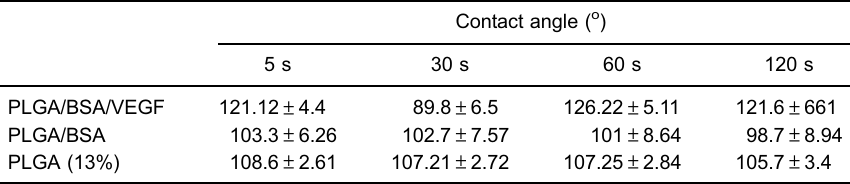
Table 1. Measurements of the contact angle in the PLGA/BSA/VEGF, PLGA/BSA and 13% PLGA at different time periods in seconds